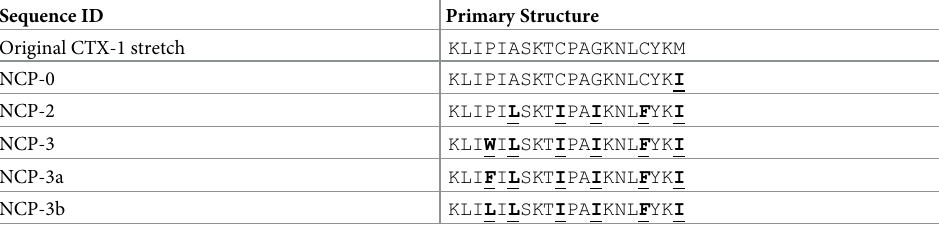
ln Table 1, the sequences of NCP-2, NCP-3, NCP-3a and NCP-3b are incorrect. Specifically, the glycine (G) residue in position 13 is incorrectly substituted with isoleucine (I). Addition- ally, the substitutions in these sequences are not formatted correctly. They should be marked in bold and underlined. The publisher apologizes for this error. Please see the corrected Table 1 here. Table 1. Amino acidic sequences of peptides belonging to the NCPs